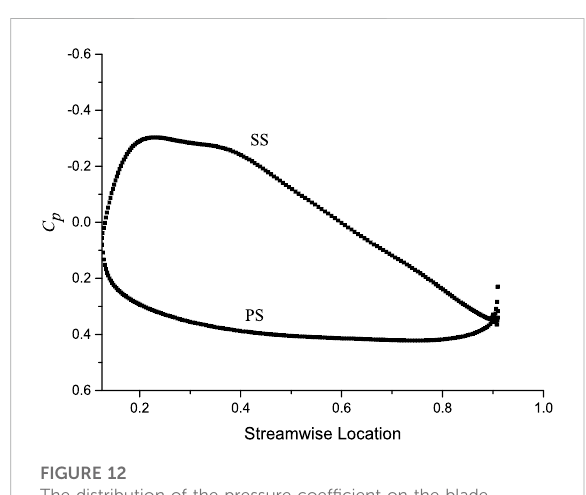
FIGURE 12 The distribution of the pressure coef fi cient on the blade surface at the radial coef fi cient of